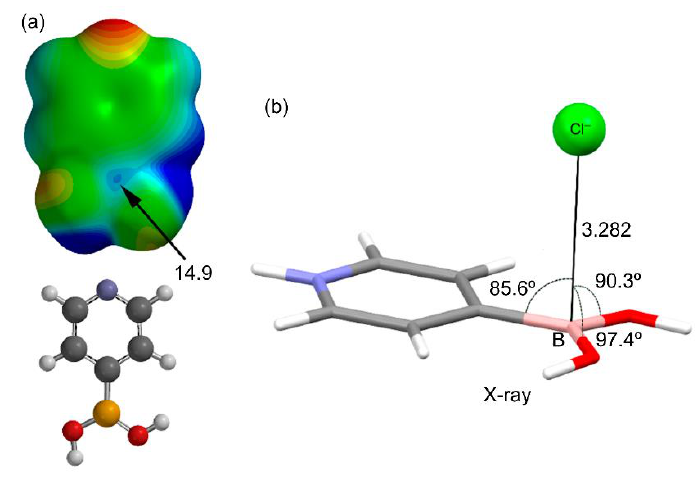
Figure 8. ( a ) Molecular electrostatic (MEP) surfaces of 4-pyridinylboronic acid with indication of the MEP value at the π -hole in kcal · mol − 1 . ( b ) X-ray structure of the hydrochloride of 4-pyridinylboronic acid. The anion is located over the π hole at the boron atom. Distances in Å .